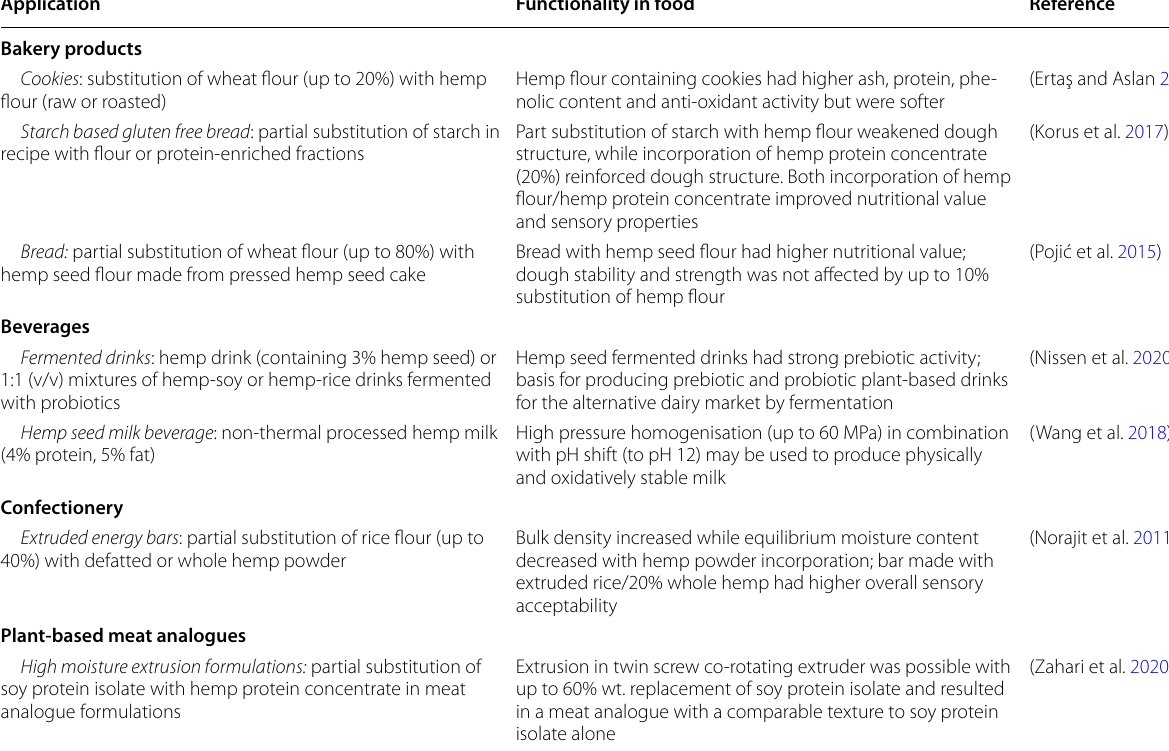
Table 2 Applications of hemp seed products in food Application Functionality in food Bakery products